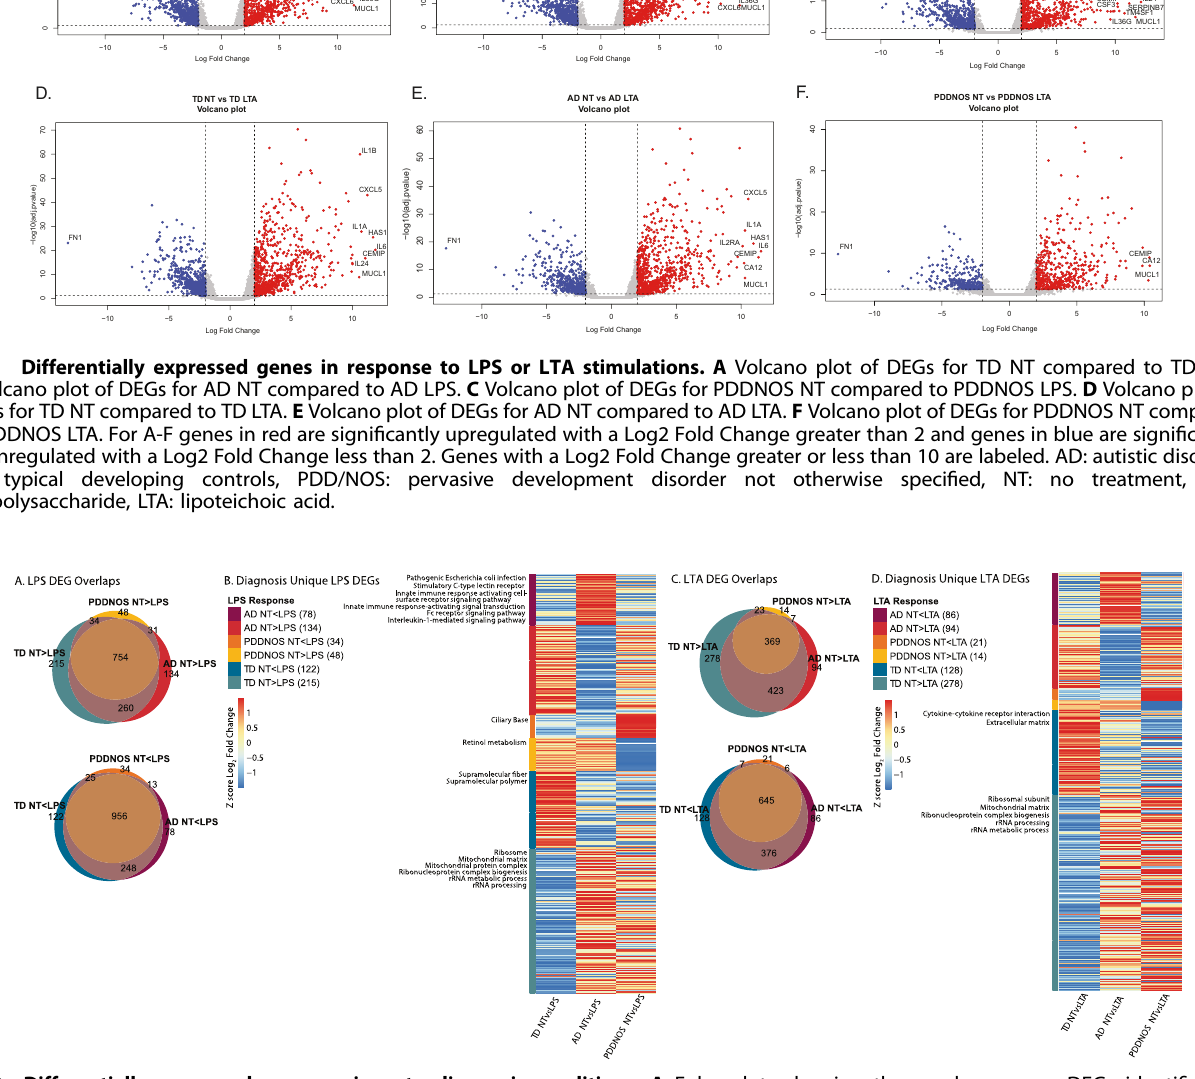
ribosome, rRNA metabolism and processing (Fig. 2D and Table S7). The majority of genes uniquely decreased in TD did not overlap between the LTA and LPS treatment conditions (Fig. 3). For example, of the genes that uniquely decreased expression in TD, only 54 were shared between LPS and LTA conditions (Fig. 3A). However, these genes contained both the ribosomal and translation-relevant genes identi fi ed in the GO term analysis in Fig. 2 (Table S8).